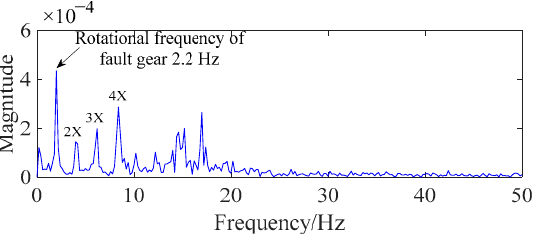
9 of 16 Figure 10. The spectrum of overload-current signal.